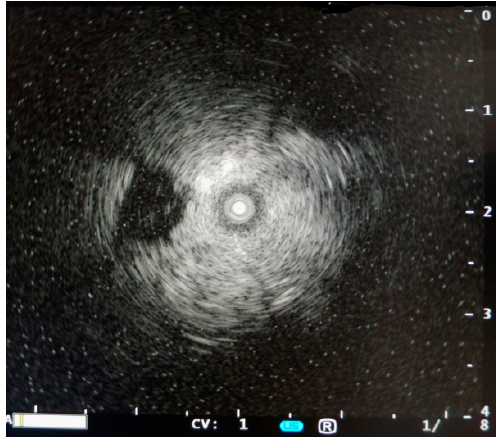
Figure 6. Sonographic imaging of hypoechoic Non-Small-Cell Lung Carcinoma (NSCLC) in saline flooded lung using ex-vivo human lung models (With permission from Lesser et al. [18]).